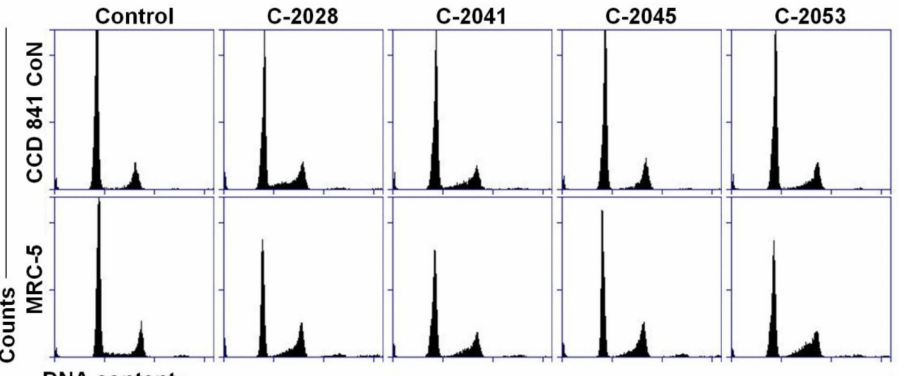
Figure 5. Cell cycle distribution of normal CCD 841 CoN and MRC-5 cells. Cells were untreated (control) or treated with 0.04, 0.05, 0.4 and 0.2 µ M of C-2028, C-2041, C-2045 and C-2053 compounds, respectively, for 120 h, and subjected to propidium iodide staining and flow cytometry analysis, as described in Materials and Methods. Histograms show the number of cells ( y -axis) versus DNA content ( x -axis) and are representative of three experiments for each condition ( n =